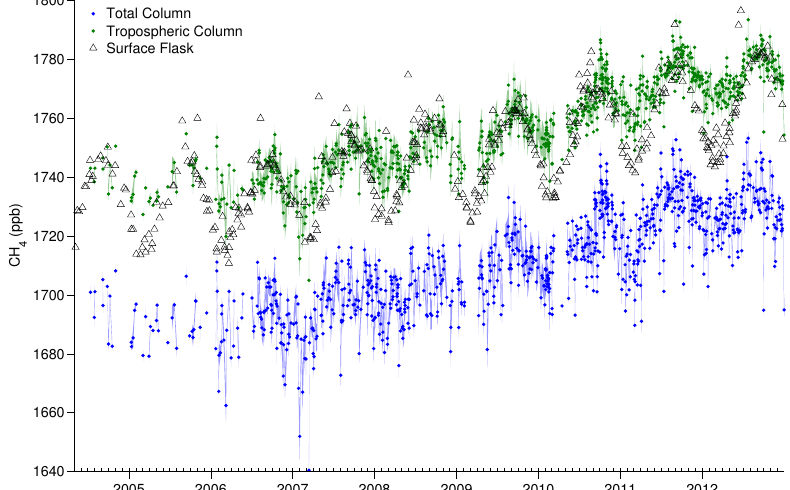
Figure 10. Daily median CH 4 DMFs at Lauder (FTS) and Baring Head (flask). Both the 120HR (June 2004–December 2010) and 125HR (February 2010–December 2012) instruments are plotted for Lauder. Total and tropospheric column DMFs are the same as in Fig.